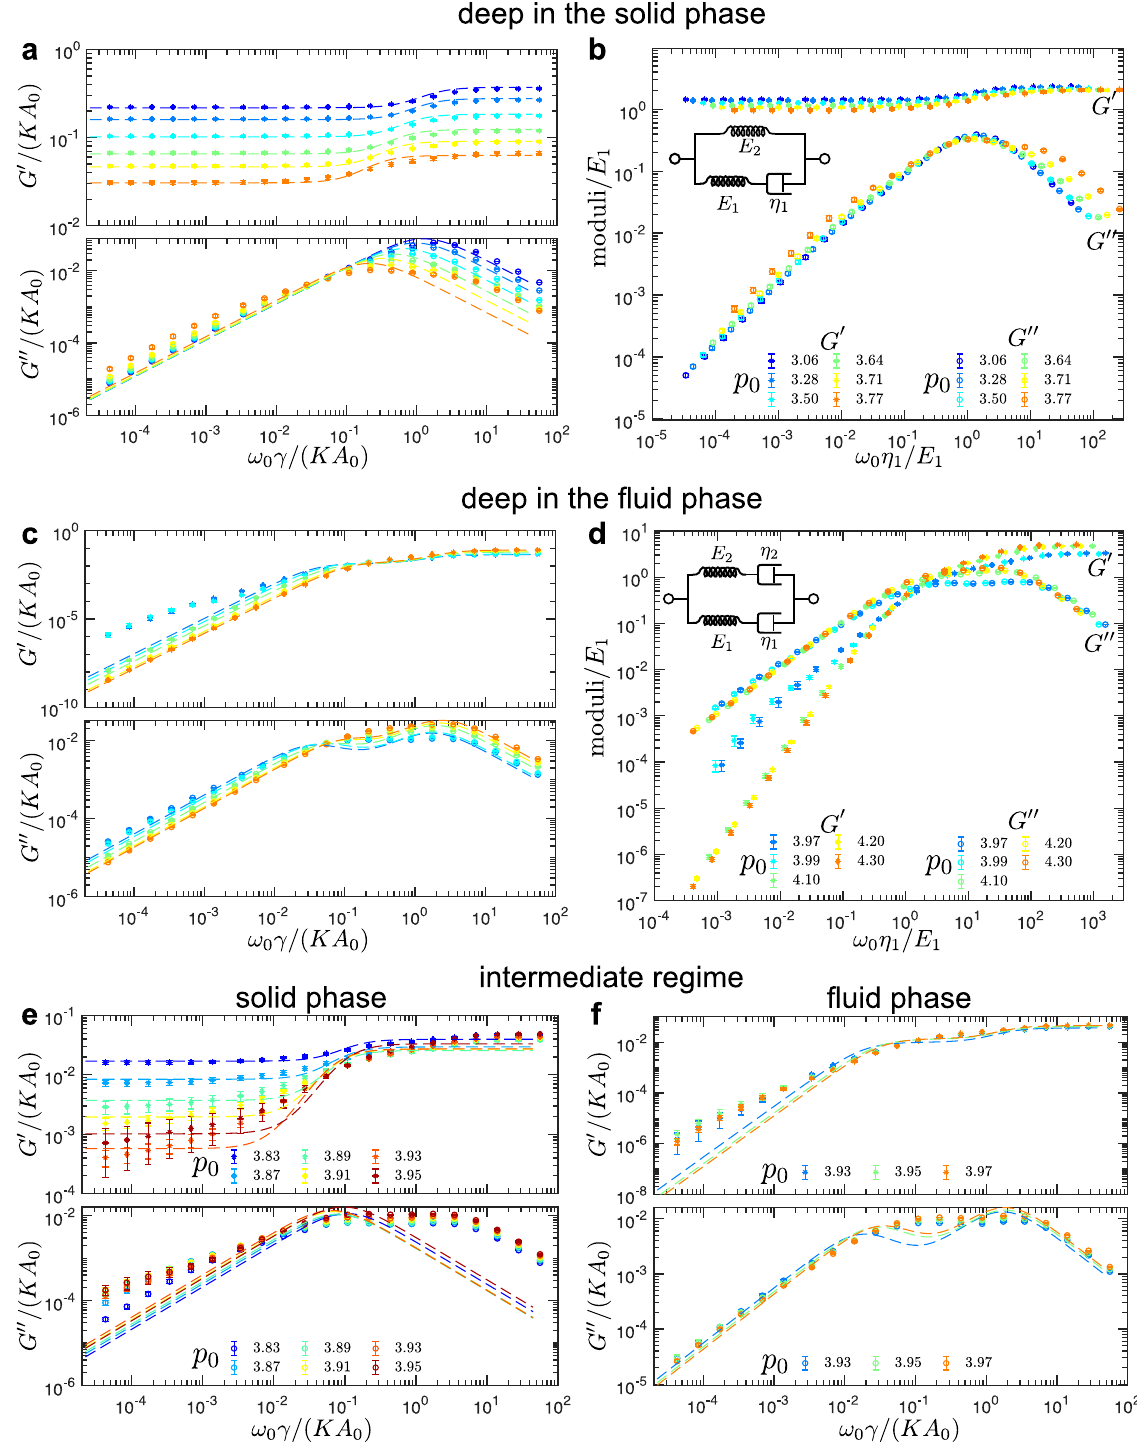
Fig 4. Average storage and loss shear moduli in the solid and fluid phase for disordered tilings. (a,c) Average storage ( G 0 ) and loss ( G 00 ) shear moduli as functions of the shearing frequency, ω 0 , for different values of the cell-shape parameter, p 0 , (a) deep in the solid phase and (c) deep in the fluid phase. The error bars represent the standard error of the mean. (b,d) The collapse of the moduli curves for different values of p 0 for (b) the solid phase and (d) the fluid phase. The insets show the representation of (b) the Standard Linear Solid (SLS) model and (d) the Burgers model in terms of the springs and dashpots. (e,f) Average storage ( G 0 ) and loss ( G 00 ) shear moduli as functions of the